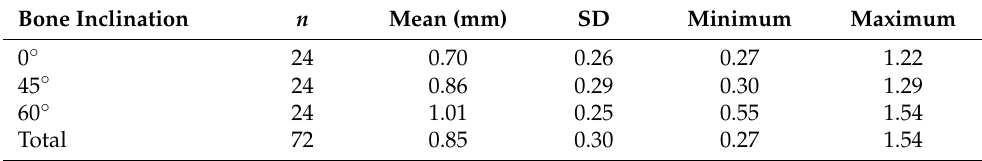
Table 10. Results of descriptive statistics of 3D deviation at apex in varying bone inclinations.